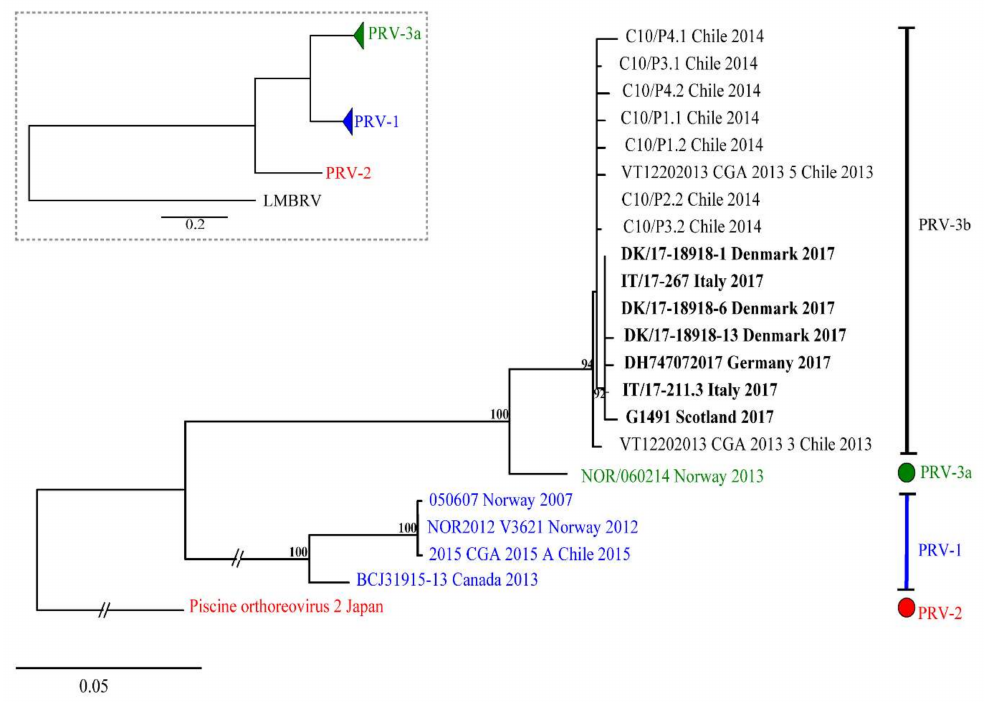
Figure 6. Phylogenetic analysis of partial nucleotide sequence of S1 segment of various PRV-3 isolates. The inner box represent the tree topography drawn in scale 0.5. Tree shows two PRV-3 clades, PRV-3a, and PRV-3b with strong